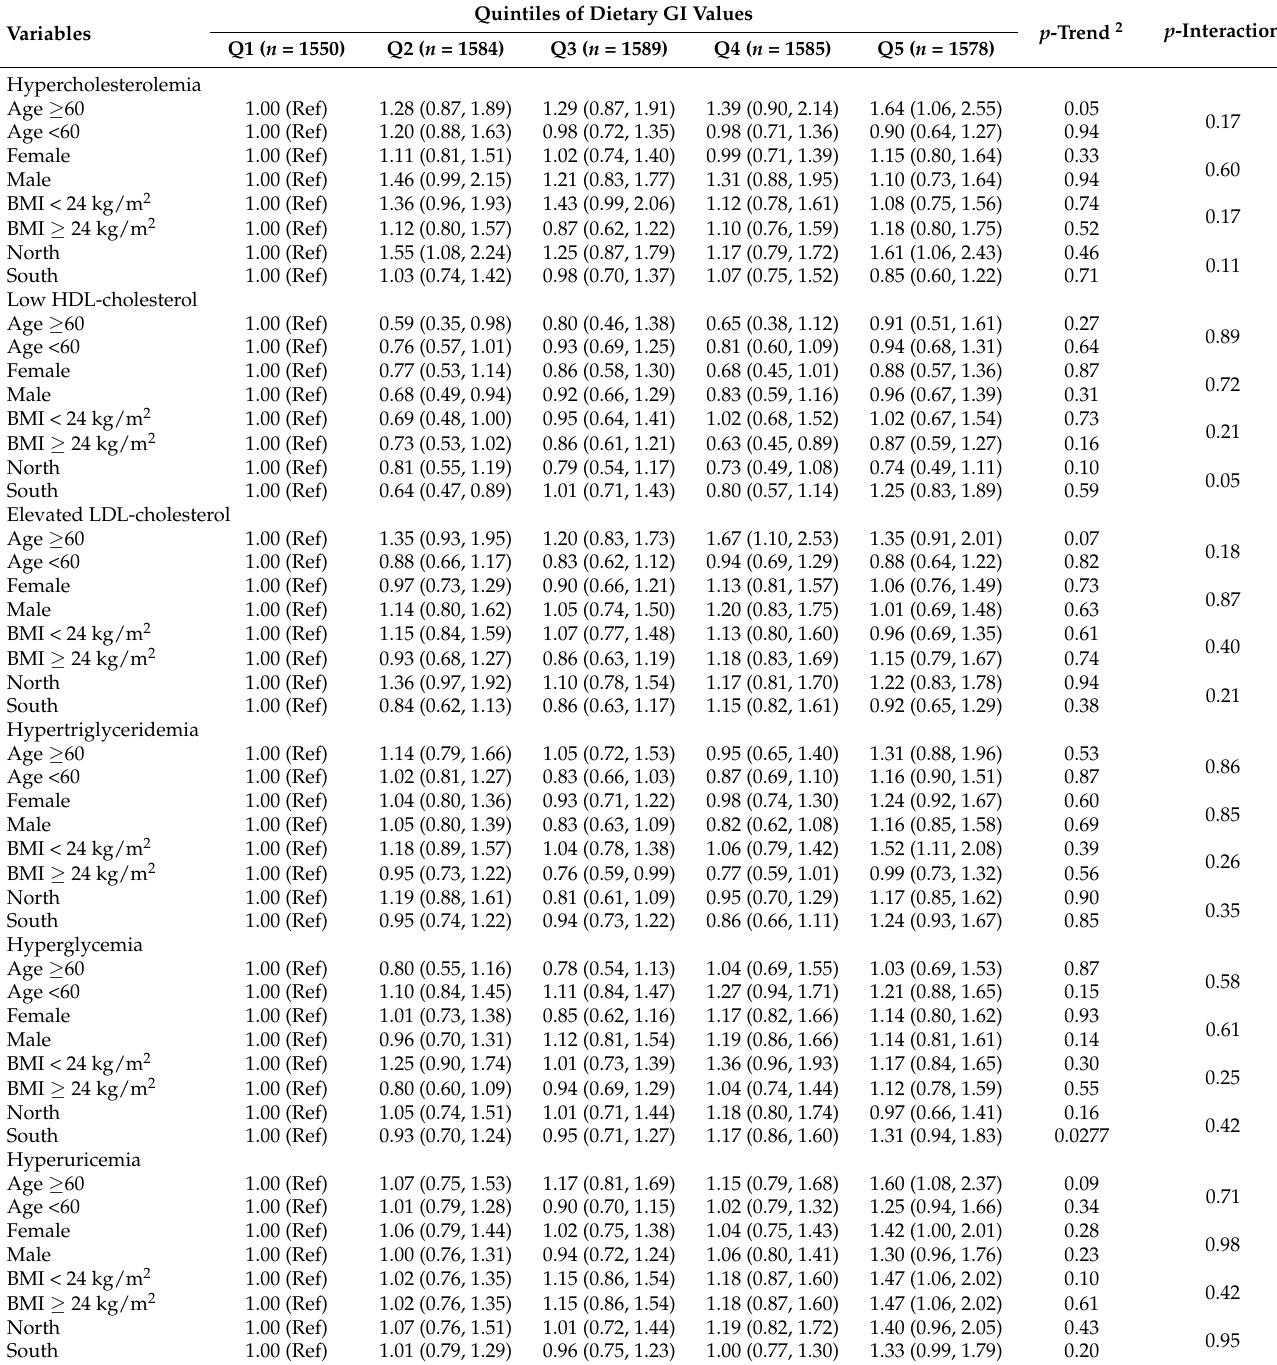
Table 4. The associations between quintiles of dietary GI values and cardiometabolic risk factors of 7886 Chinese adults who participated in the China Health and Nutrition Survey 2009, stratified by age, sex, BMI, and region ( N = 7886) 1